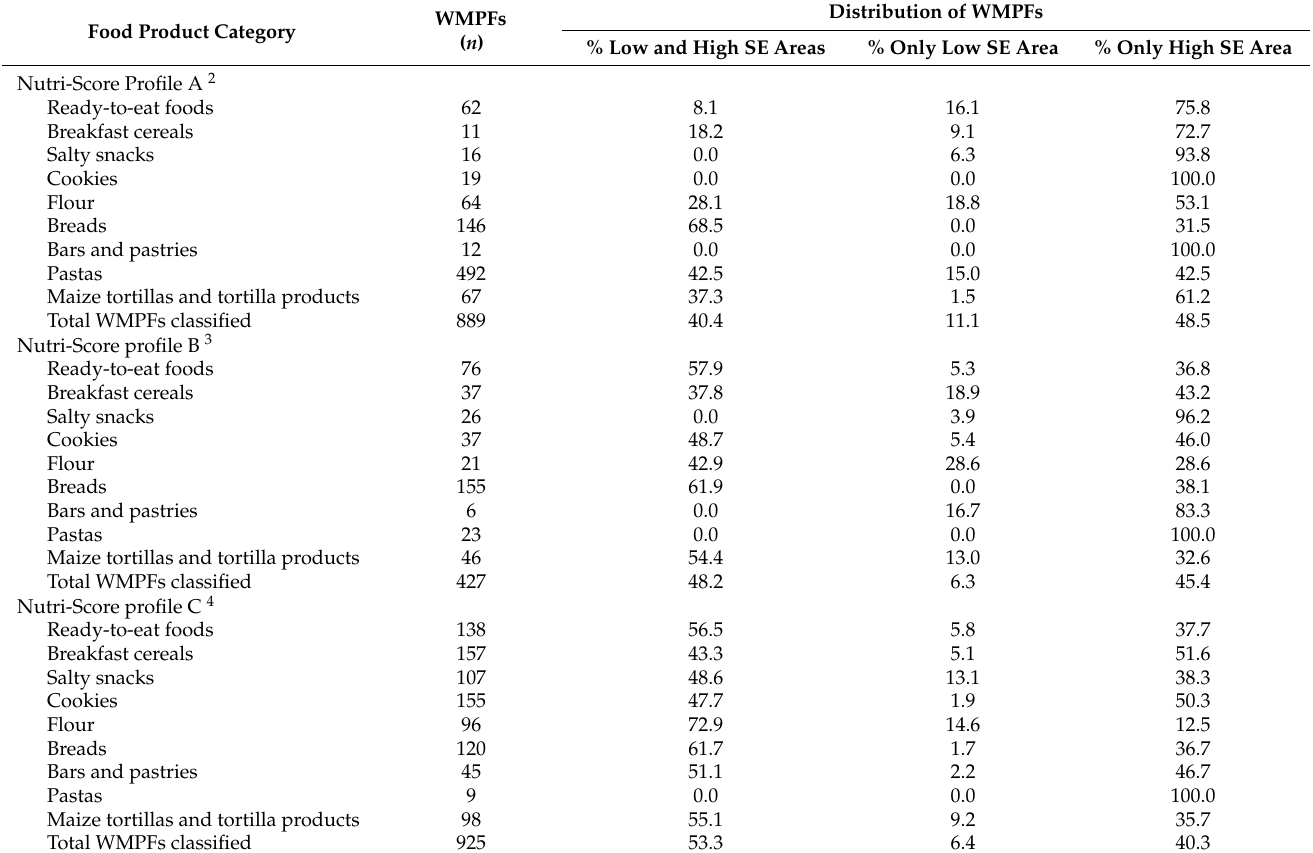
Table 2. Distribution of WMPF categories across Nutri-Score profiles 1 and SE